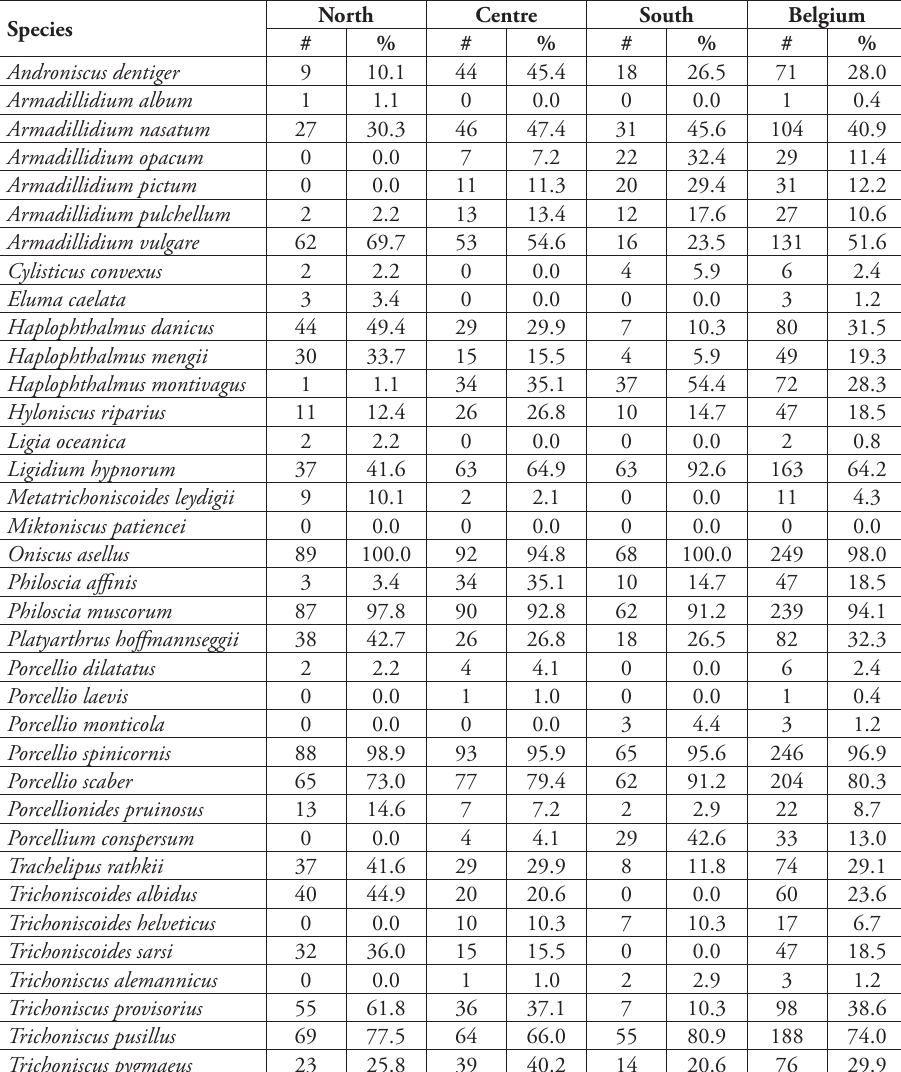
Table 4. Number of visited squares where a certain species is recorded and their relative occurrence per region and